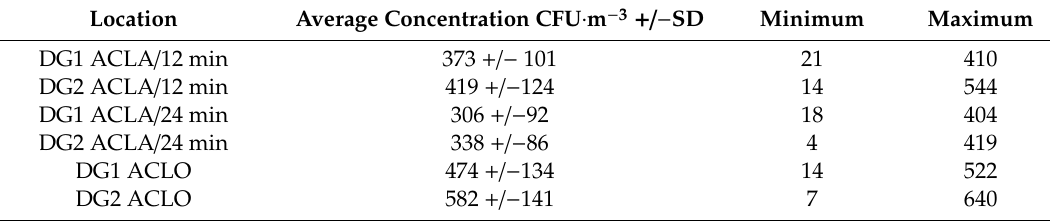
Table 2. Average concentration and standard deviation (SD) of fungal aerosol colony-forming units